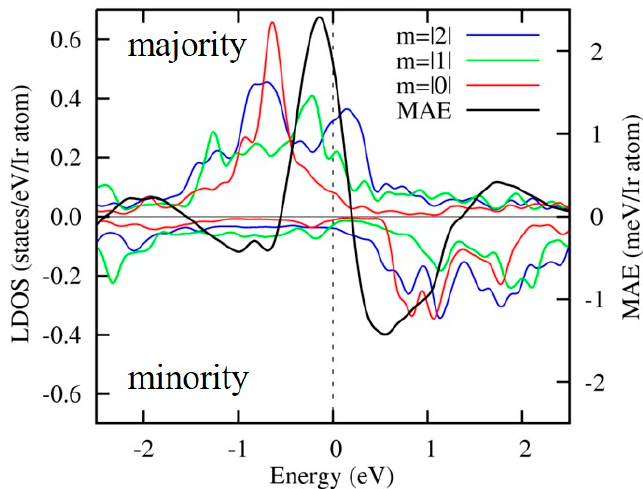
Figure 16. Spin polarized local density of states of Ir-5 d orbitals and magnetic anisotropy energy as a function of the band energy in layer 2.